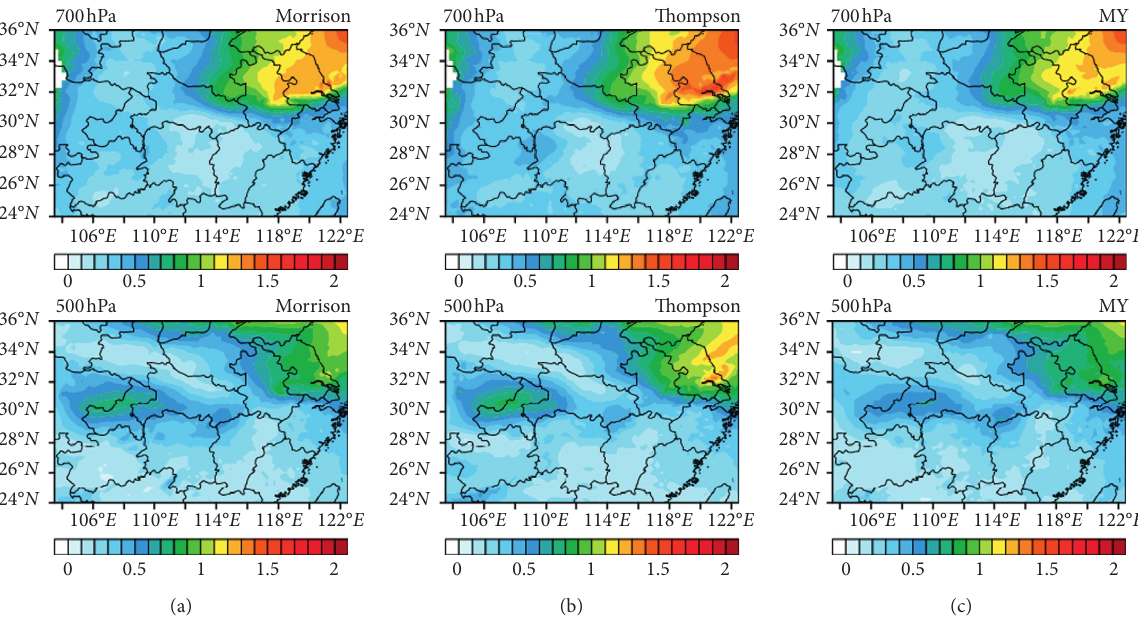
Figure 8: The same as Figure 7 except for the three experiments: (a) Morrison, (b) Thompson, and (c) MY. 1 and 2 indicate 700hPa and 500hPa,